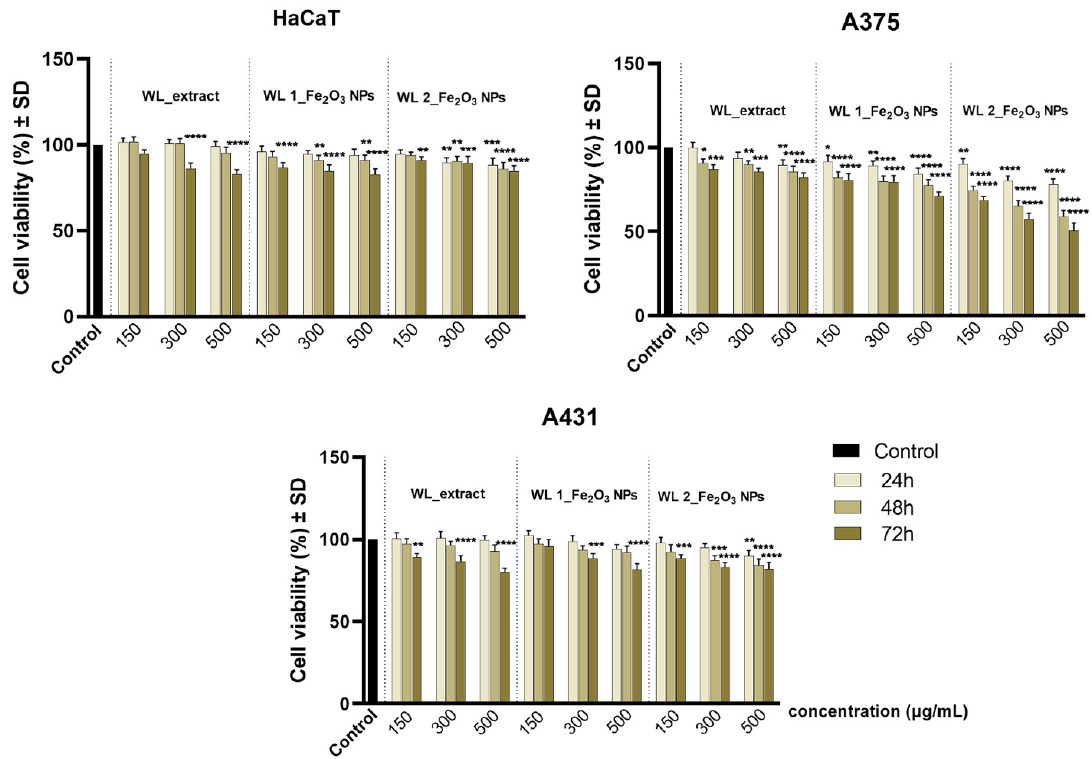
Figure 11. Cell viability percentage of immortalized human keratinocytes (HaCaT), human amelanotic melanoma cells (A375) and human epidermoid carcinoma cells (A431) after treatment with wormwood leaves extract (WL_extract) and two different Fe 2 O 3 NPs obtained from this extract (WL 1_Fe 2 O 3 NPs; WL 2_Fe 2 O 3 NPs) at three different concentrations (150, 300, 500 µg/mL) for in- tervals of 24, 48, and 72 h. The viability percentage of sample-treated cells was normalized to the